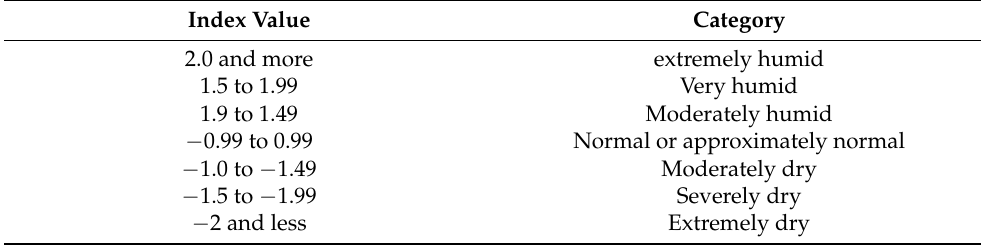
Table 1. Values of the Standard Precipitation Index